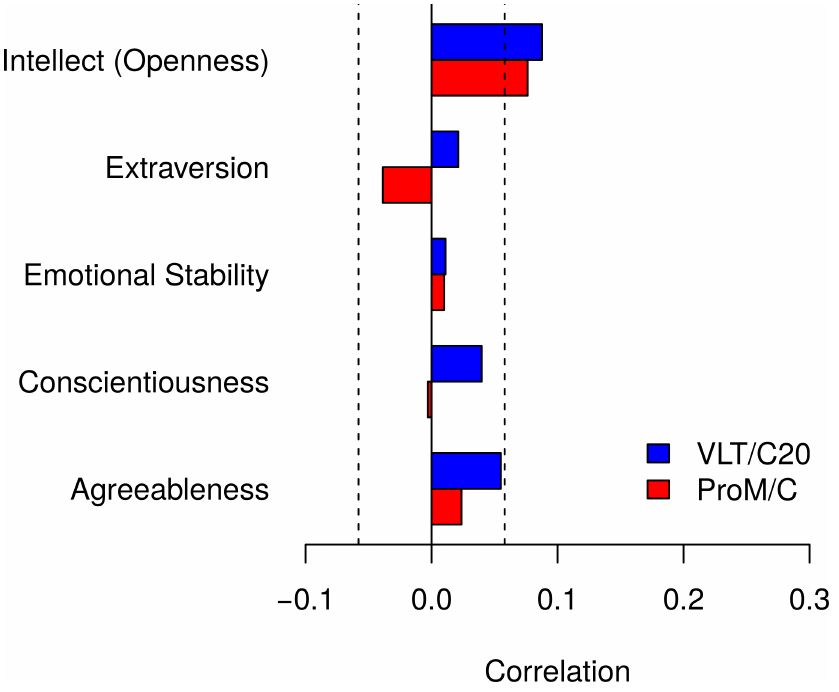
Fig 3. Correlations between ProM and personality. Both ProM and RetM correlated only with Openness and the two correlations were comparable. The dashed lines indicate p = .05